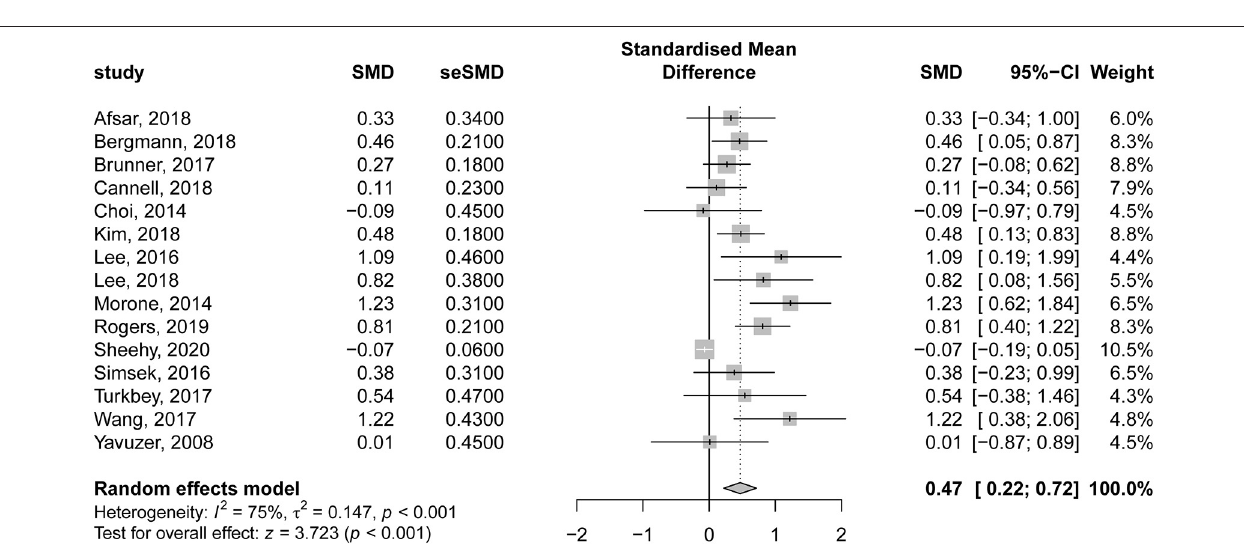
FIGURE 5 | Forest plot for the comparative effectiveness of virtual reality–based rehabilitation of motor function vs. conventional therapy in subacute stroke